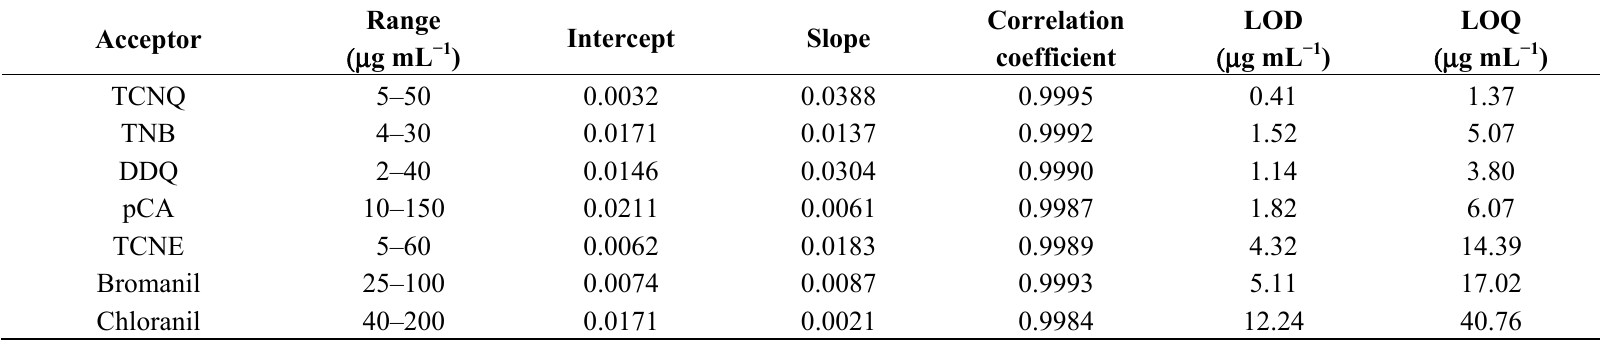
Table 2. Quantitative parameters for the determination of ROS-Ca based on its CT reaction with various π -acceptors.